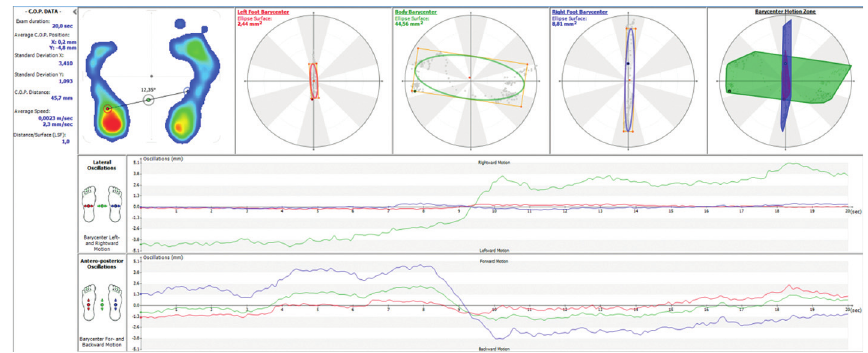
Figure 14: The result of the balance test for patient no.